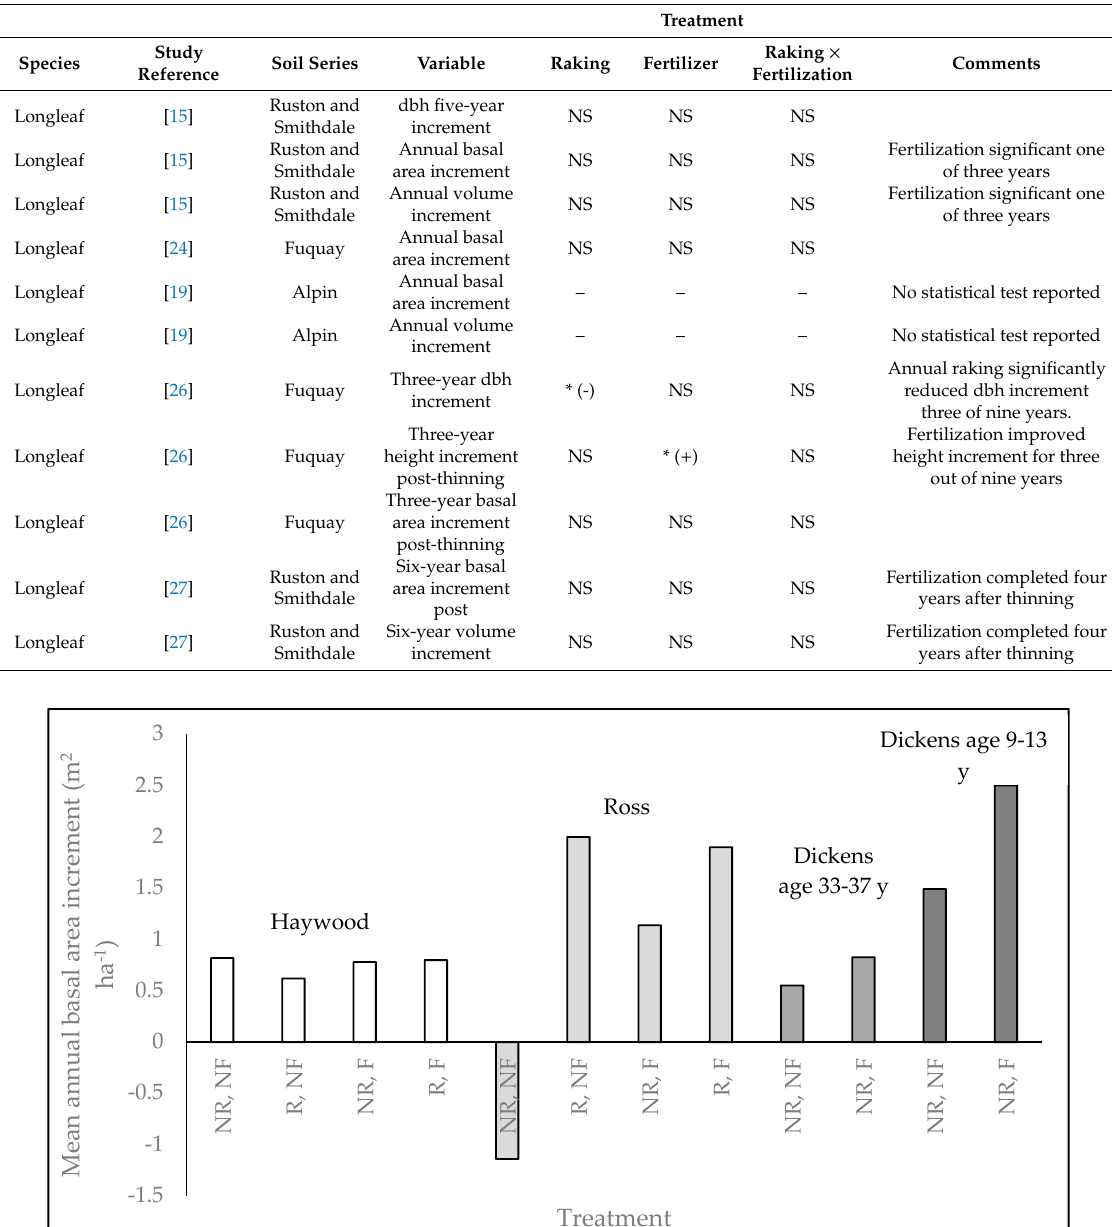
Table 5. Summarization statistical test results for longleaf pine growth and yield variables by treatment, soil series, and study. Non-significant (NS), ‘* (-)’ and ‘* ( + )’ indicates either a negative or positive response associated with significant variables (*), and ‘—‘ indicates that a statistical test was not reported for that variable and treatment combination.